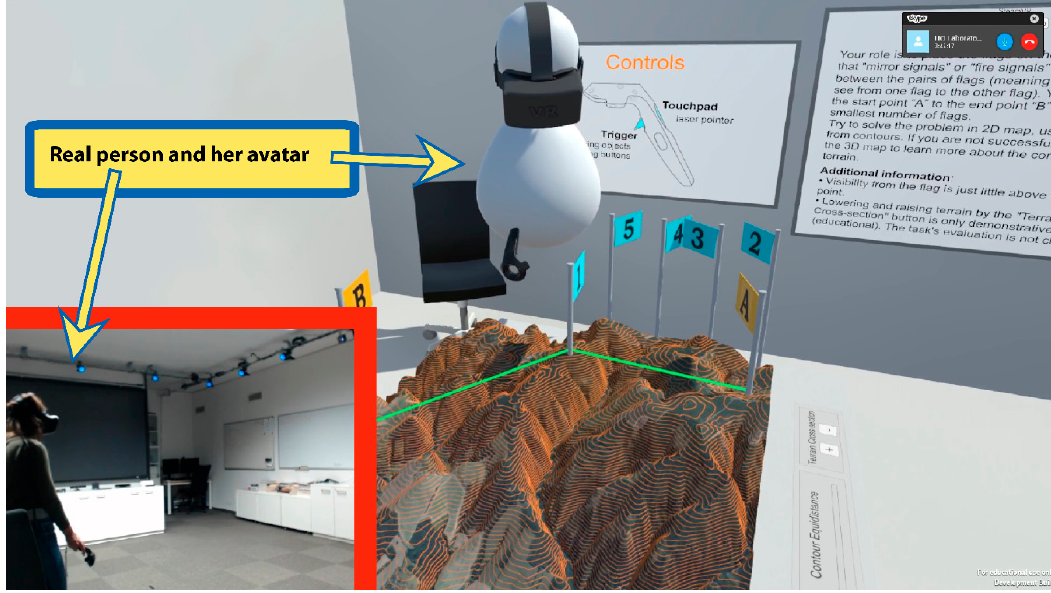
Figure 1. Objective reality (left corner) and virtual room.